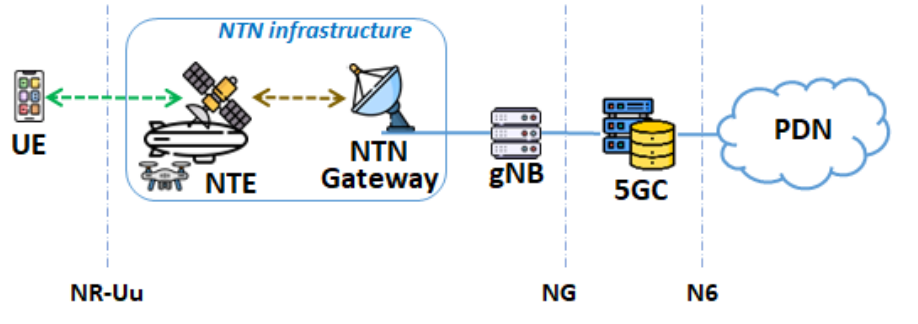
Figure 2. Transparent NTN architecture.